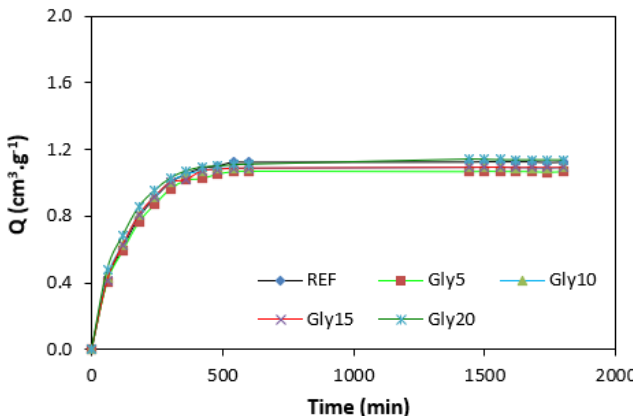
Figure 11. Swelling indexes of vulcanizates NBR/CB-L30.